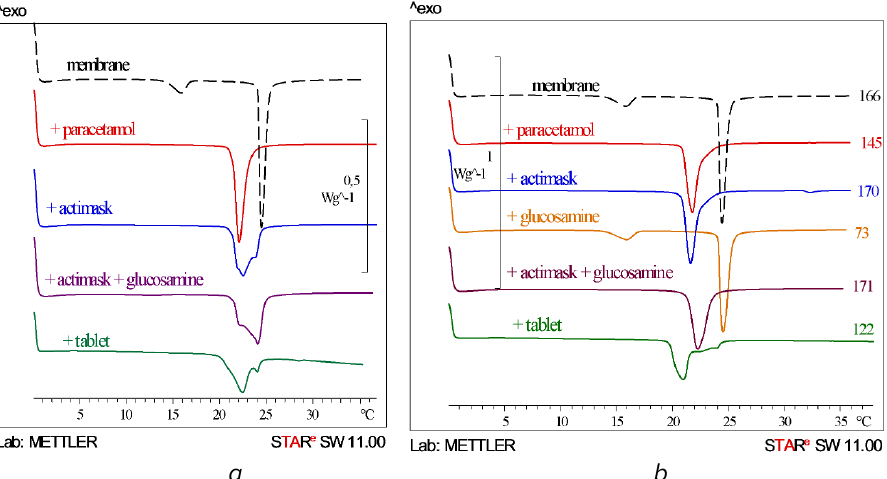
Fig. 4. Normalized DSC profiles of lipid membranes containing pharmaceuticals: a – after 3 hrs since the start of exper- iments; b – after systems equilibrium (time (hrs) is indicated in numbers on the right of the curves). DSC profiles of the neat lipid membrane are marked with dotted